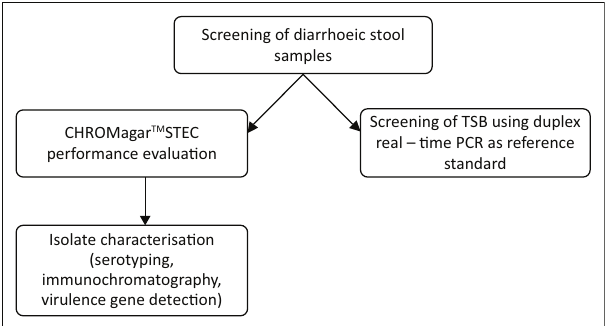
FIGURE 1: Summary of methods used in this study. TABLE 1: Primers and probes used for real-time polymerase chain reaction.